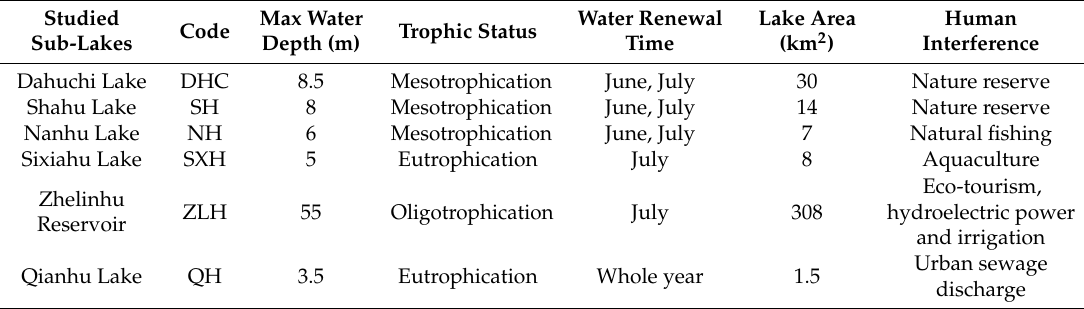
Table 1. Study site. Code, number of sites, sampling periods and human interference in the six studied sub-lakes (DHC, SH, NH, SXH ZLH and